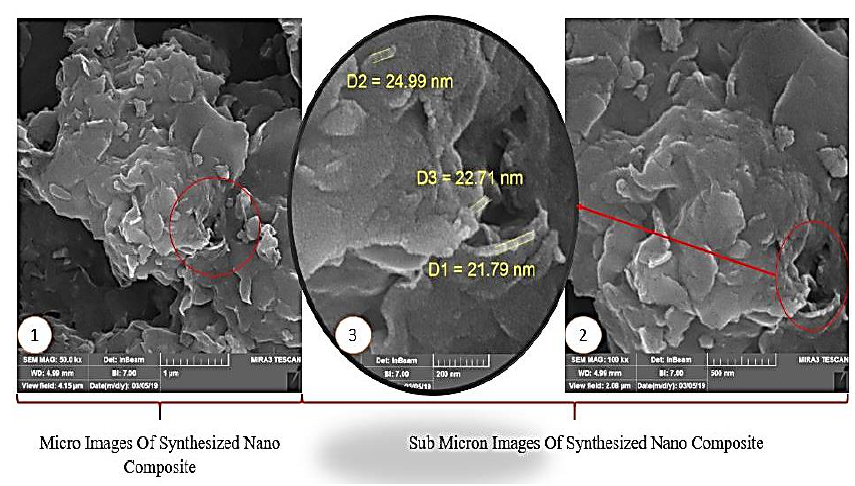
Figure 5. FESEM images from the NC showing a layer sheet surface morphology with particle sizes ranging from 20 to 26 nm.